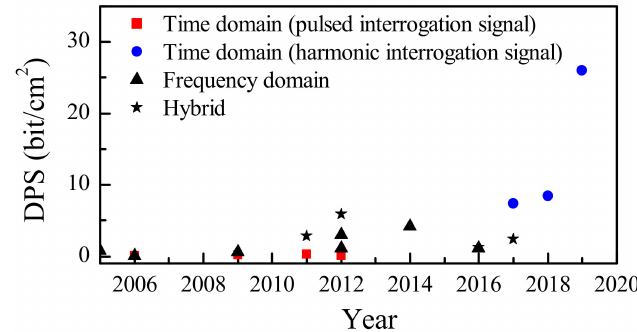
Figure 24. Historic evolution of DPS for di ff erent encoding